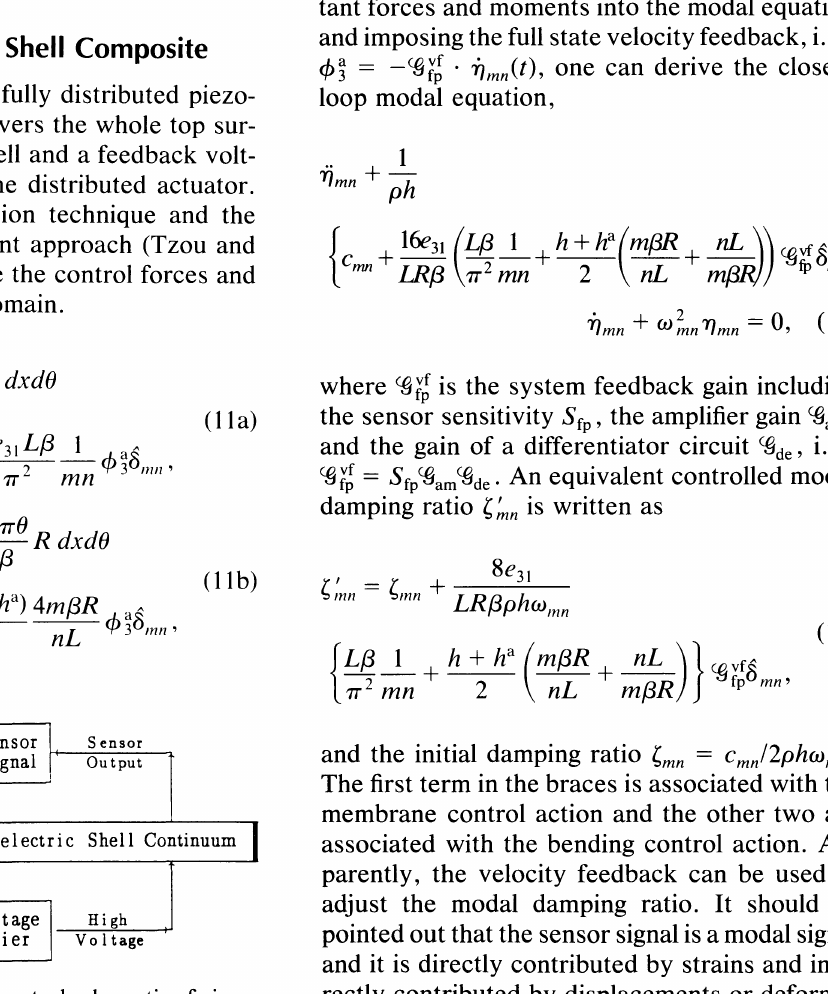
FIGURE 3 A closed-loop control schematic of piezo electric